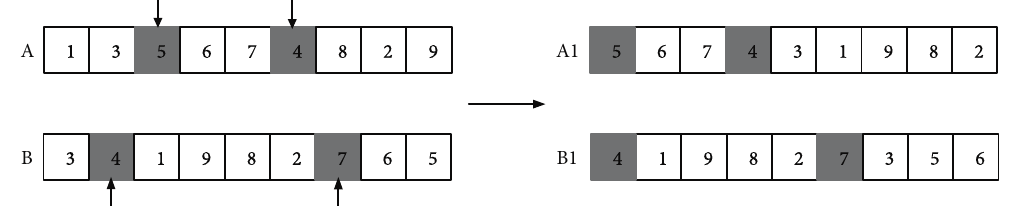
Figure 10: Schematic diagram of a sequential crossover